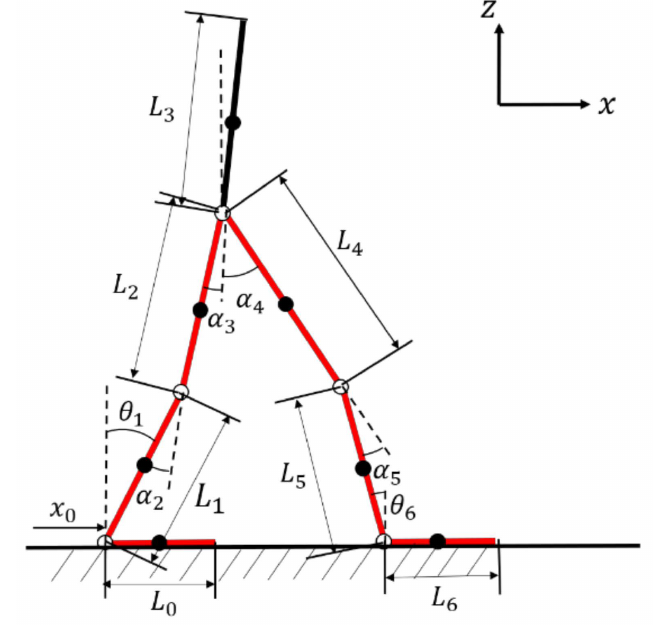
Figure 16. Double-leg support phase